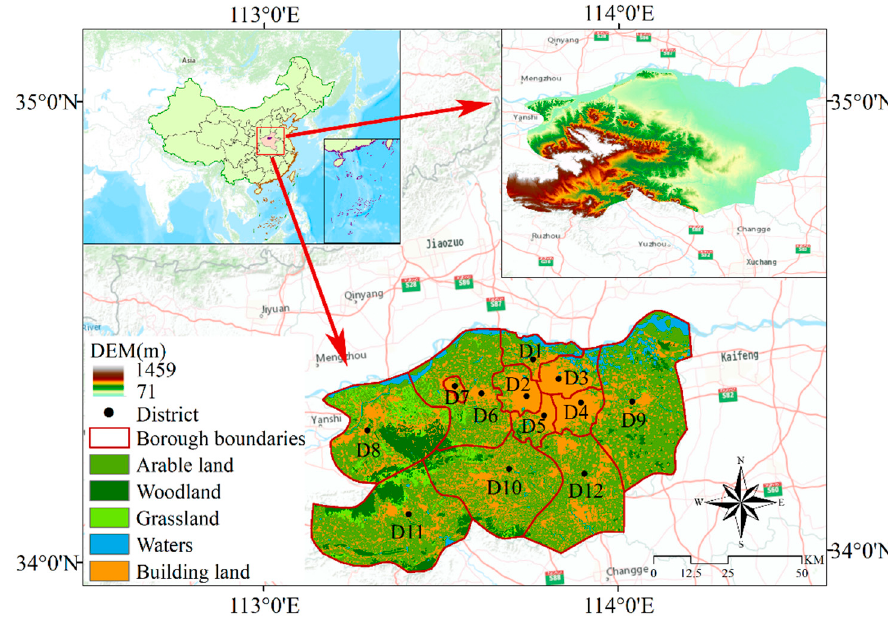
Figure 1. The location map of Zhengzhou.